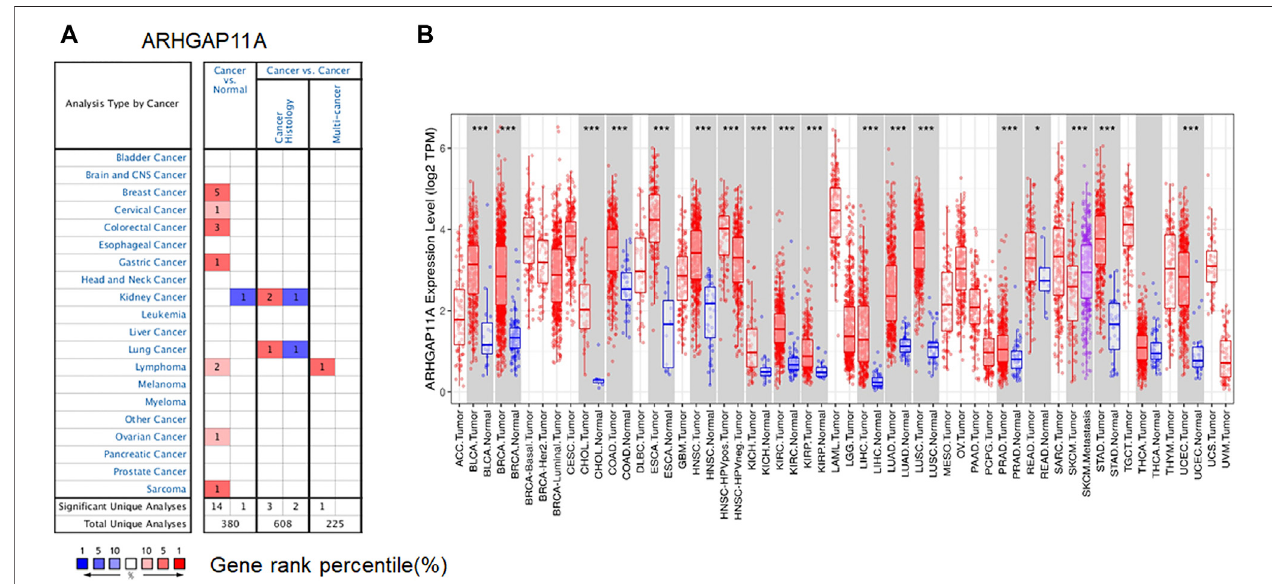
FIGURE 1 | ARHGAP11A expression in different tumor and normal tissues. (A) Oncomine. ( p -value < 1.0E − 04), Cell color is determined by the best gene rank percentile for the analyses within the cell. An analysis may be counted in more than one cancer type. (B) TIMER. (* p -value < 0.05, *** p -value < 1.0E −